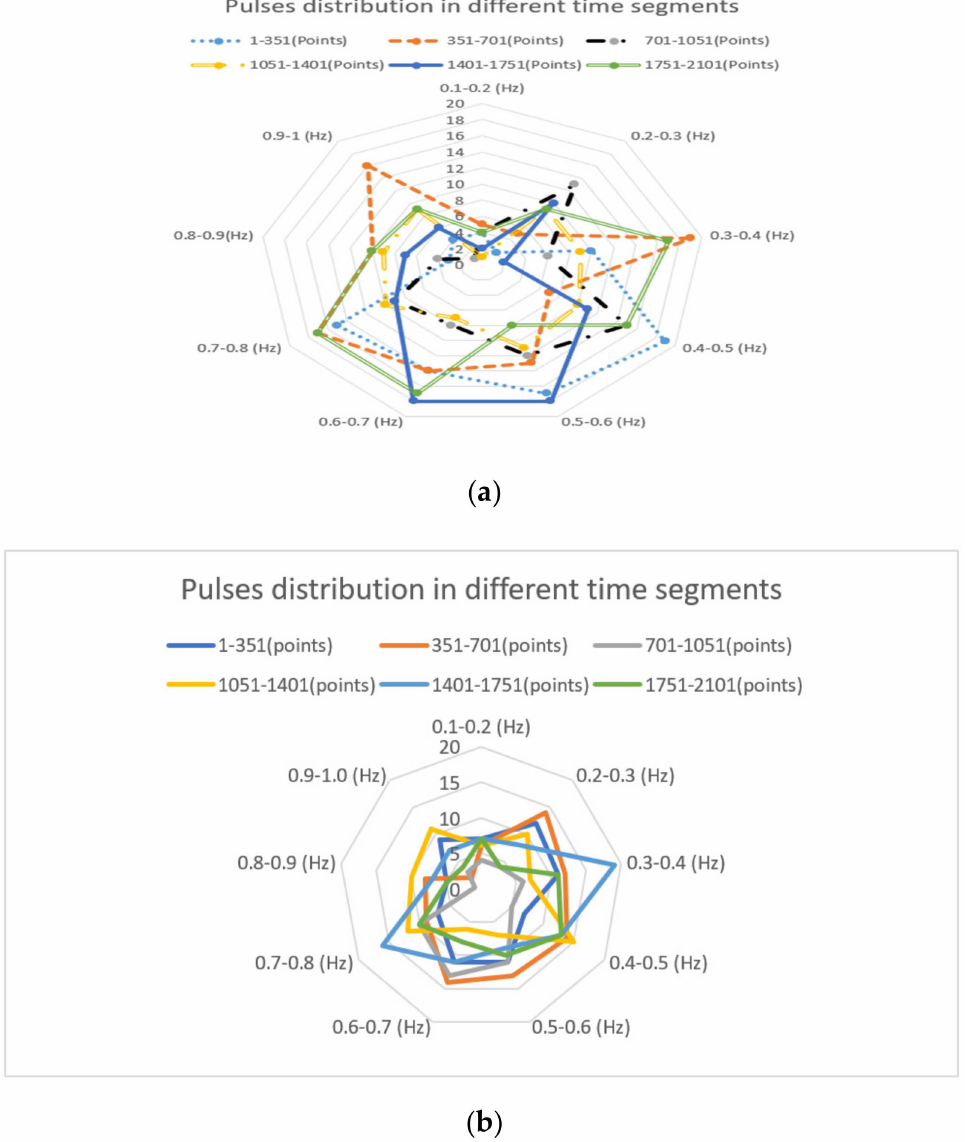
Figure 12. Pulse distribution in different time segments of another two data sets: ( a ) pulse distribution of frequency ranges in different time segments of an abnormal data set, ( b ) pulse distribution of frequency ranges in different time segments of a normal data